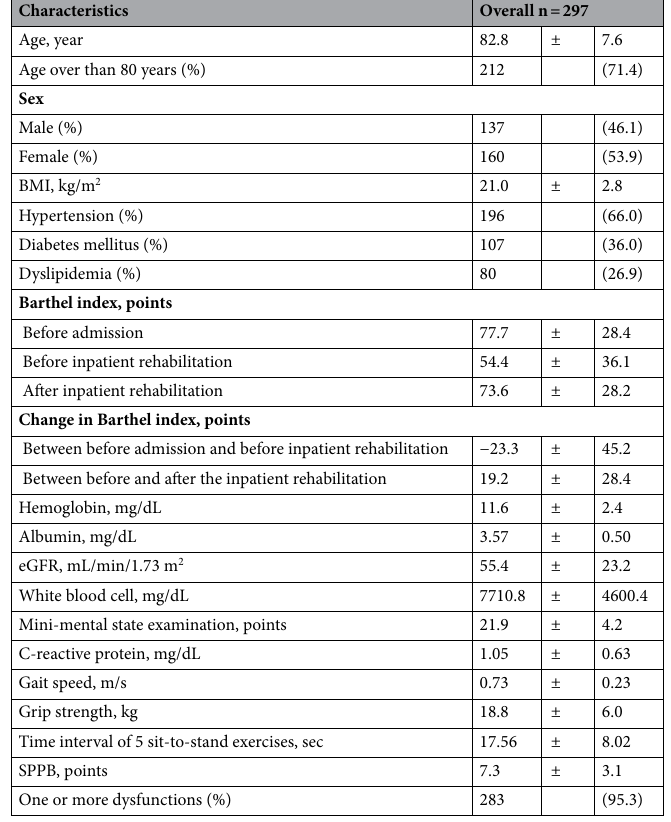
Table 1. Patient characteristics in this study. Data are presented as mean ± standard deviation unless otherwise indicated. BMI, body mass index; eGFR, estimated glomerular filtration rate; SPPB, short physical performance battery.